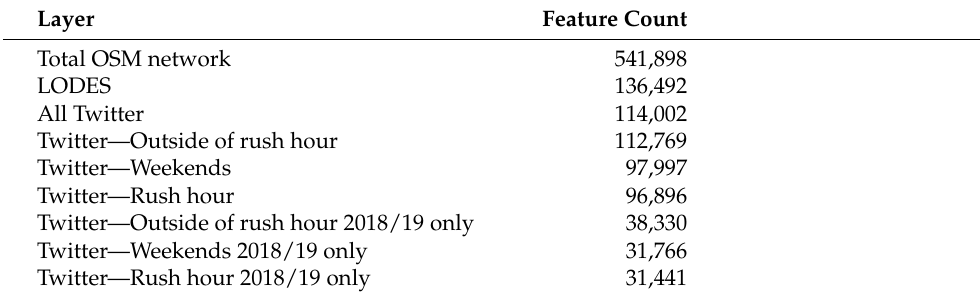
Table 2. Comparison of the comprehensiveness of the datasets used in this study. The features are the street segments of the OSM network for the study area. Layer Feature Count